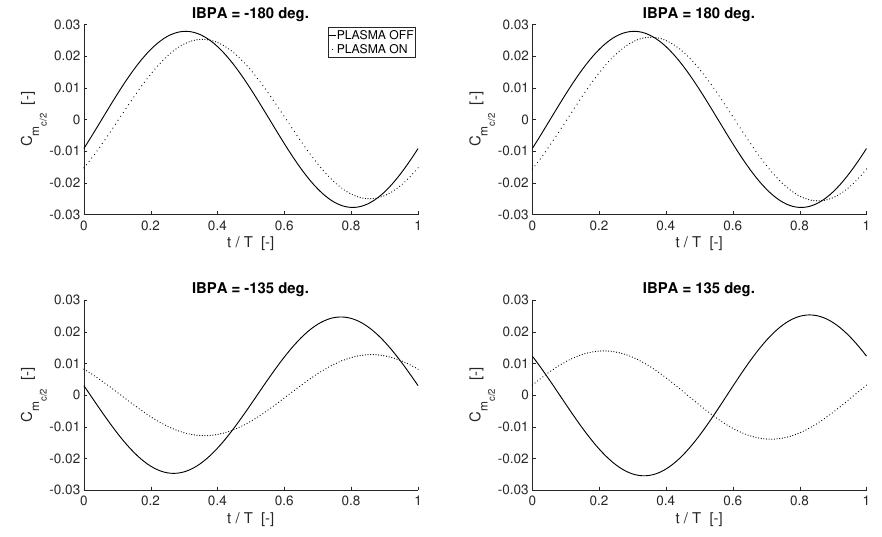
Figure 16. Time history of the mid-chord pitching moment coefficient C m for the last simulated period; Re ∼ 195,000; α = 2 + sin ( 2 π f t + 4 × IBPA π IBPA = [ ± 180, ± 135 ] degrees.